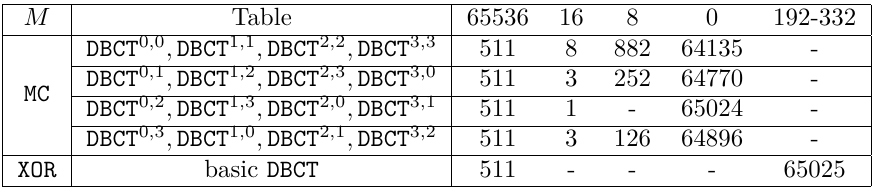
Table 3: Number of entries for each value for the DBCT i,j and the basic DBCT for the AES